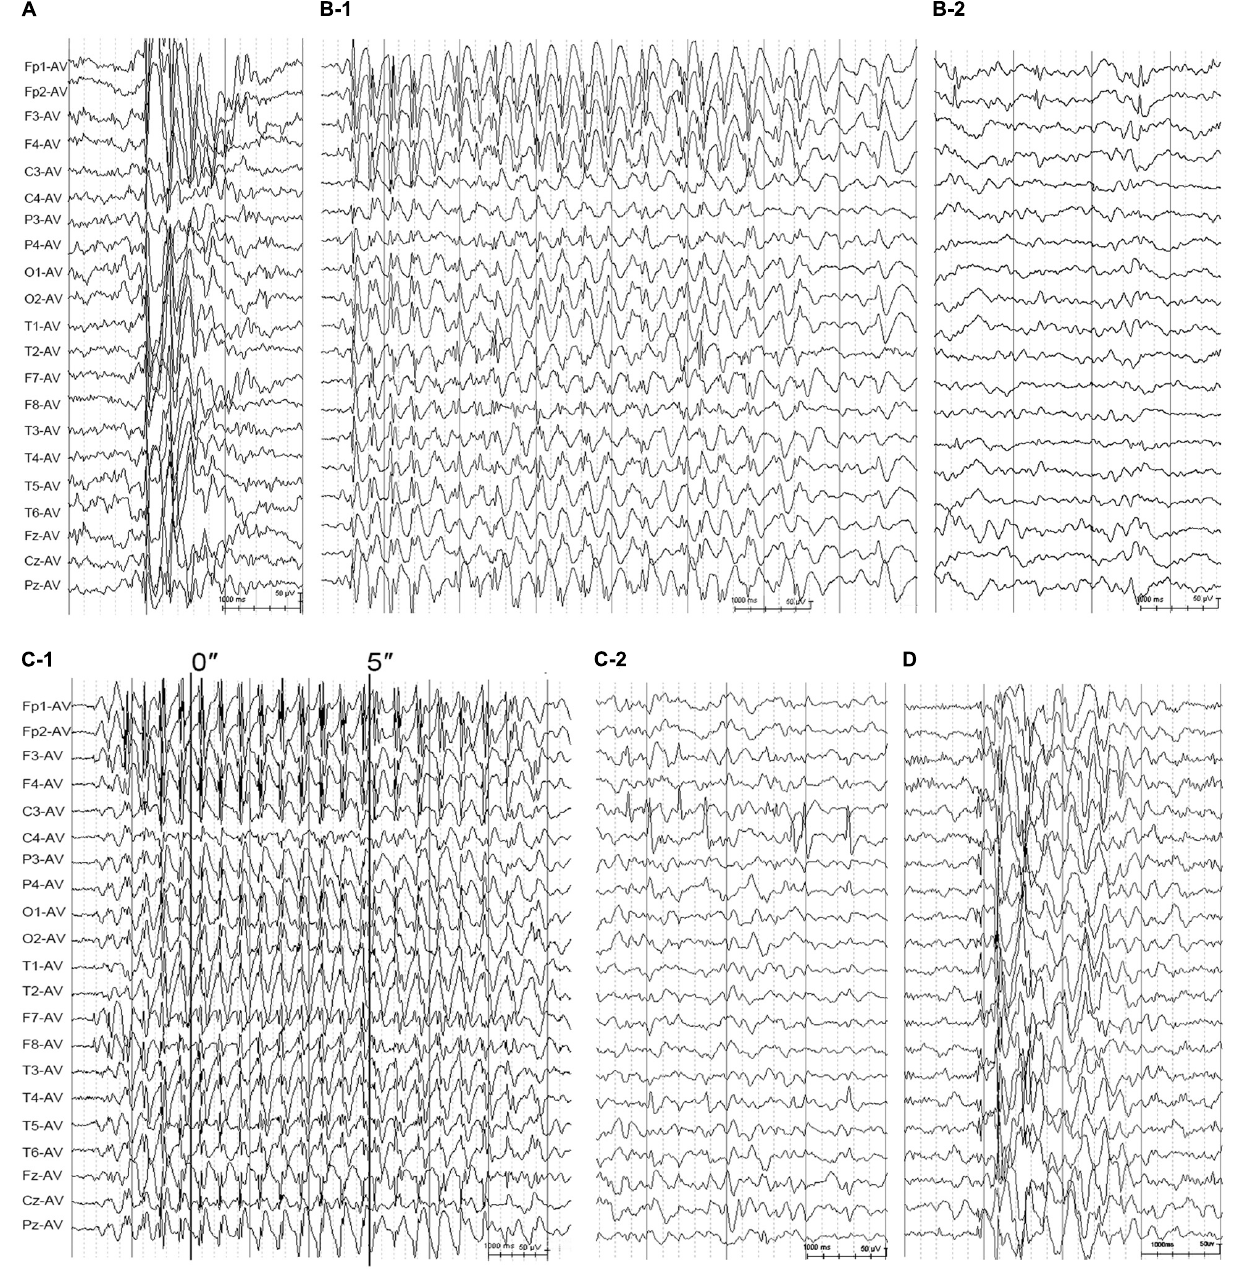
mutations were located in CTD. In this study, absence seizure-related mutations were also located in CTD. These data suggested a potential association between absence seizures and